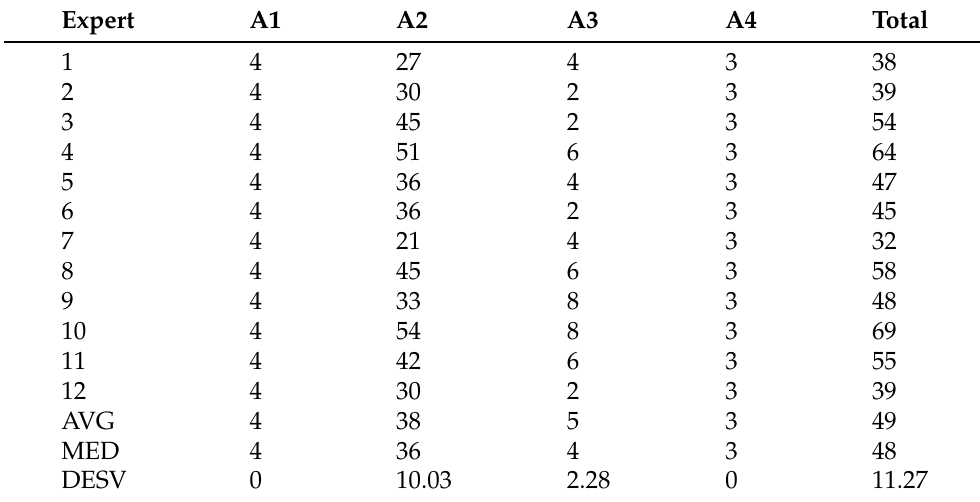
Table 2. Expert scores in the flexible point system.